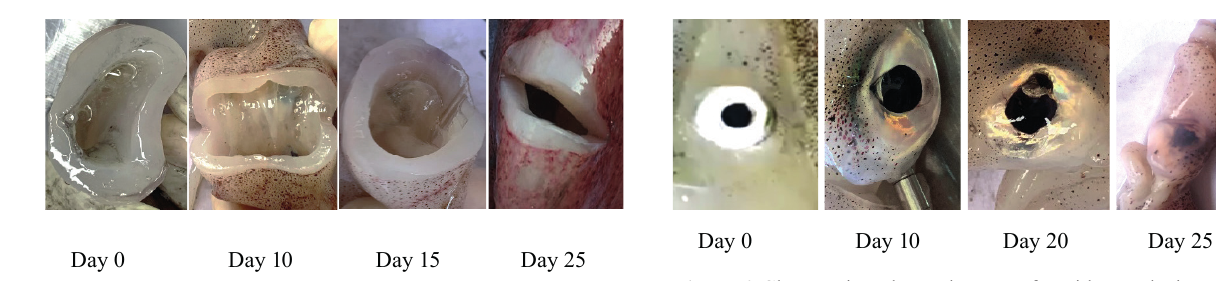
Figure 3 Changes in color and status of squid eyes during